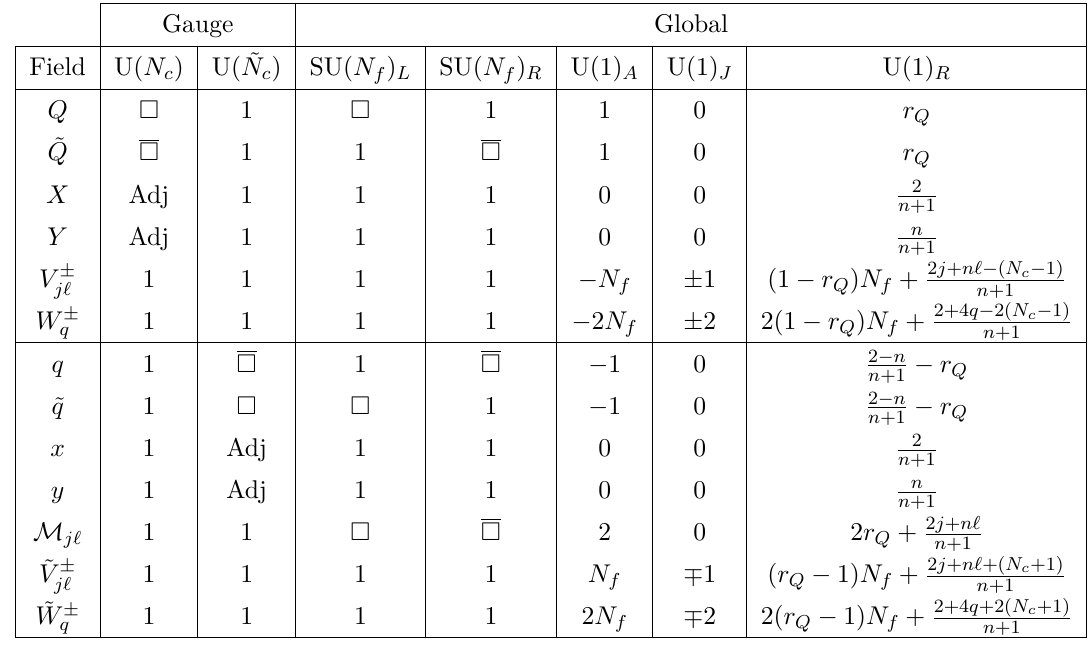
Table 1 . Matter content of electric (upper) and magnetic (lower) U ( N c ) 0